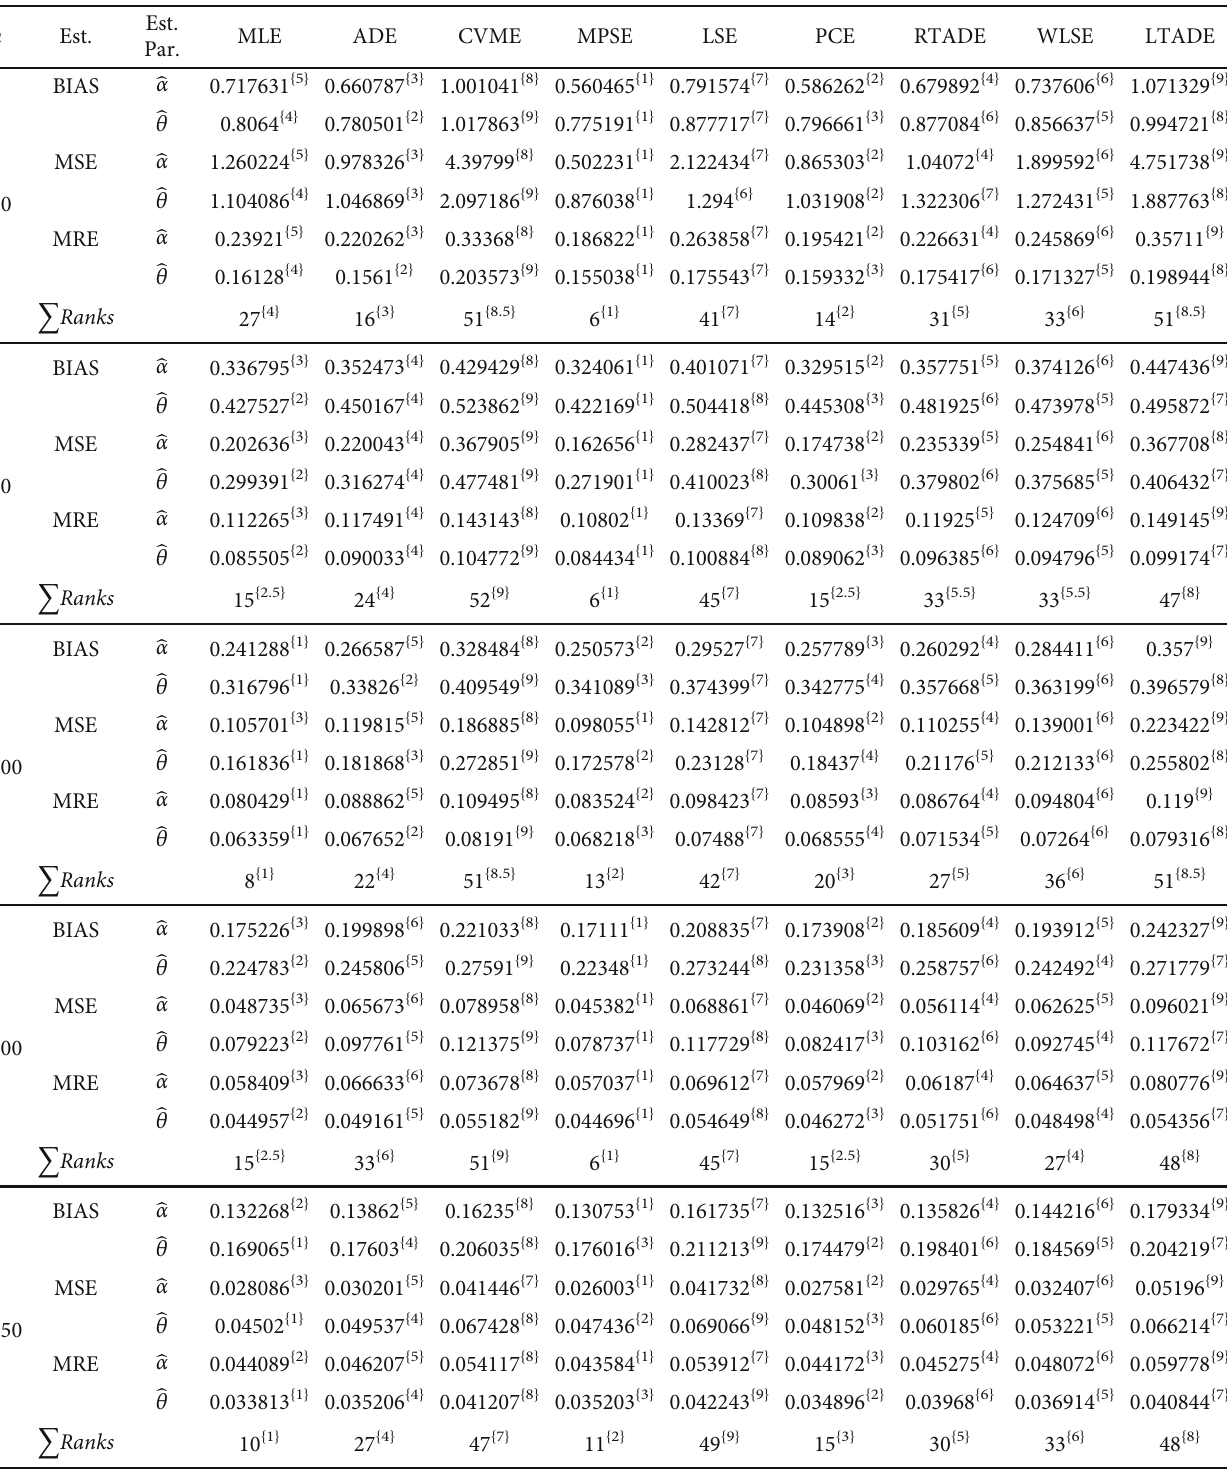
Table 6: Simulation values of BIAS, MSE, and MRE for α = 3 and θ = 5